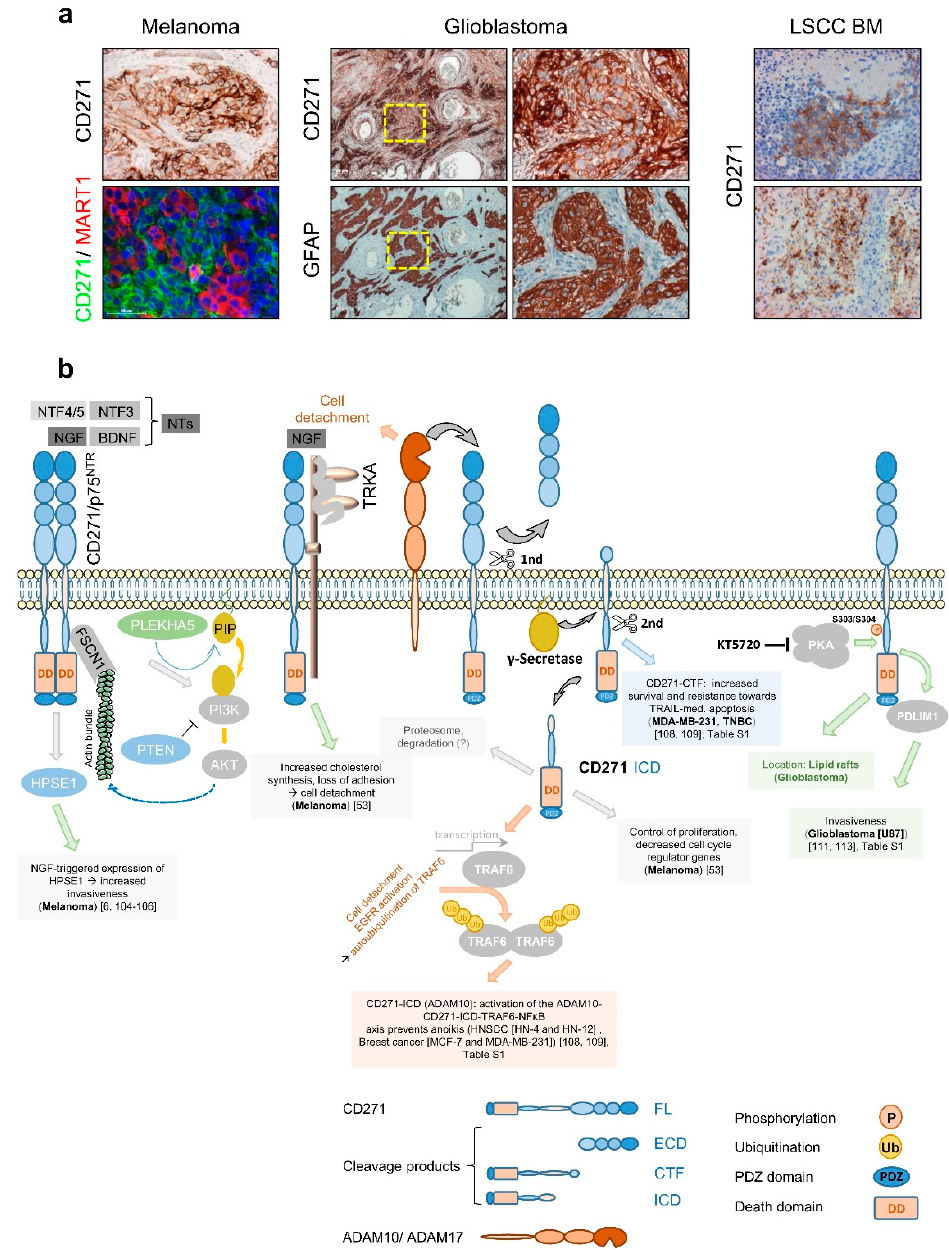
Figure 5. Expression and consequence of CD271 in melanoma and beyond. ( a ) CD271 labels a subset of tumor cells that feature a stem-like phenotype, lacking expression of melanoma / melanocyte specific markers like MART1 (first panels). The CD271 expression in GFAP + glioblastoma cells drives invasiveness and is associated with poor prognosis (center panels). Like in glioblastoma, the expression of CD271 defines a proliferative state and is associated with poor prognosis of lung squamous cell carcinoma (LSCC) and is found in BM of LSCC (right panels). ( b ) Intracellular signaling processes of CD271 are triggered by neurotrophin binding to CD271 homodimers, triggering the binding to actin bundles via fascin (FSCN1), the activation of heparanase (HPSE1), or induce PI3K / AKT-signaling and cell migration modulated by PLEKHA5. The binding of NGF to the complex of CD271 / TRKA was suggested to increase cholesterol synthesis and cell detachment via formation of the CD271-ICD fragment. The latter in turn decreased the levels of cell cycle regulators and triggered the phenotype switch from proliferation (“growing”) to invasion / migration (“going”). The intracellular processing